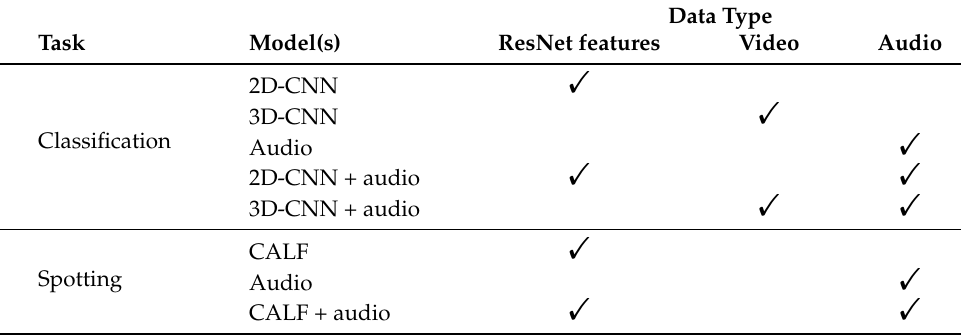
Table 2. Overview of which combination of models use which type of data, indicated by a checkmark. ResNet features are the visual features extracted using the ResNet model accompanying the SoccerNet dataset. Video is the 3D-ResNet extracted features using video frames from the games in SoccerNet. Audio is the Log-Mel spectrograms generated from the audio of the games in